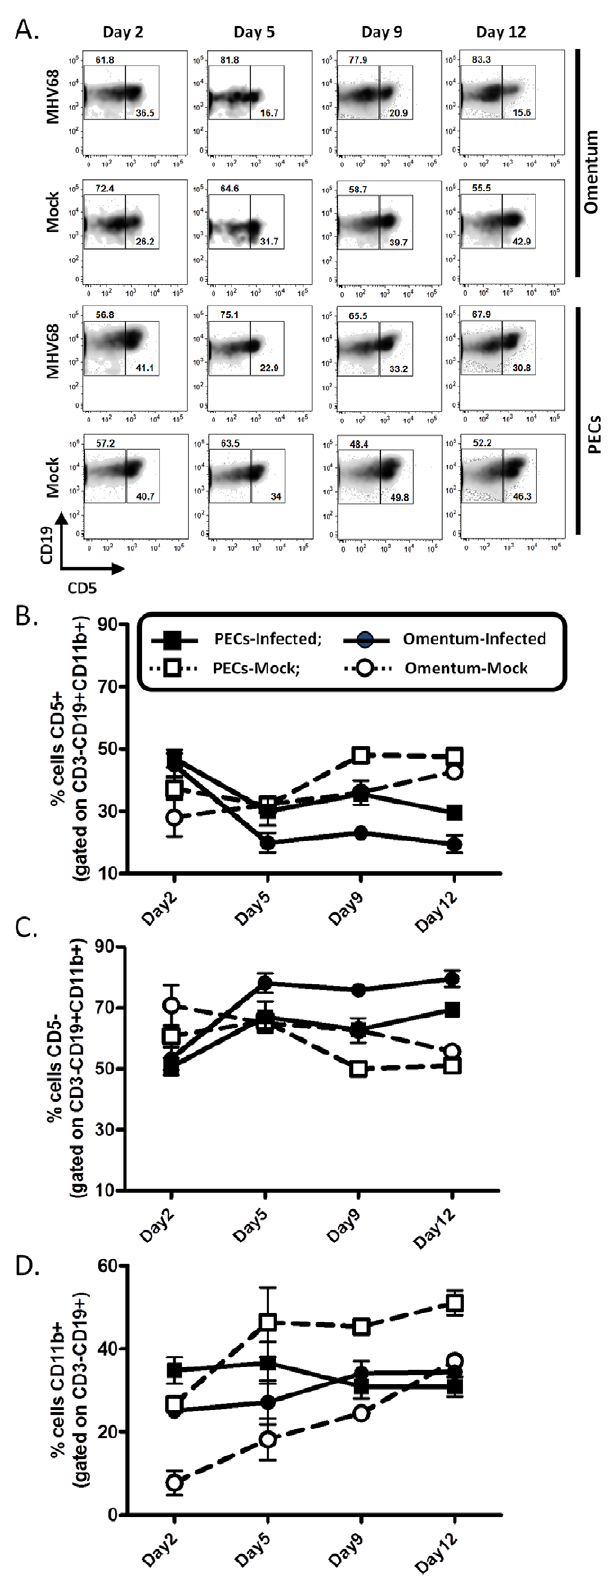
Figure 3. Alterations in B1-B cell populations in the omentum and peritoneal exudate following MHV68 infection. Cells from the omentum and peritoneal cavity (PECs) were isolated at